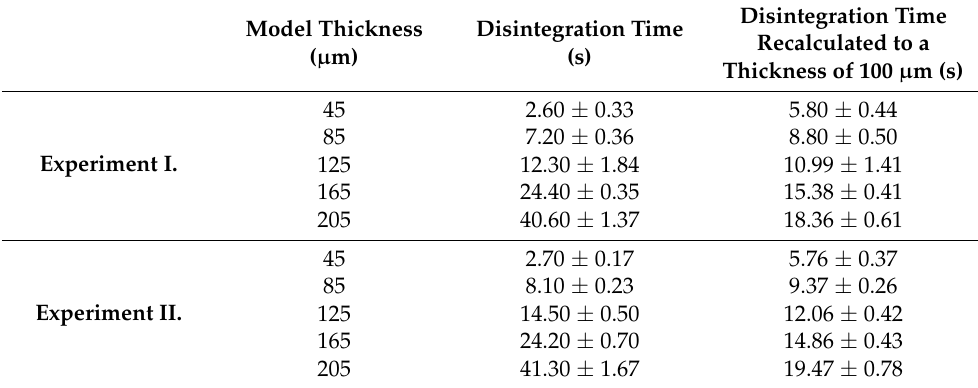
Table 4. Disintegration time of ODFs and disintegration time recalculated to a thickness of 100 µ m.